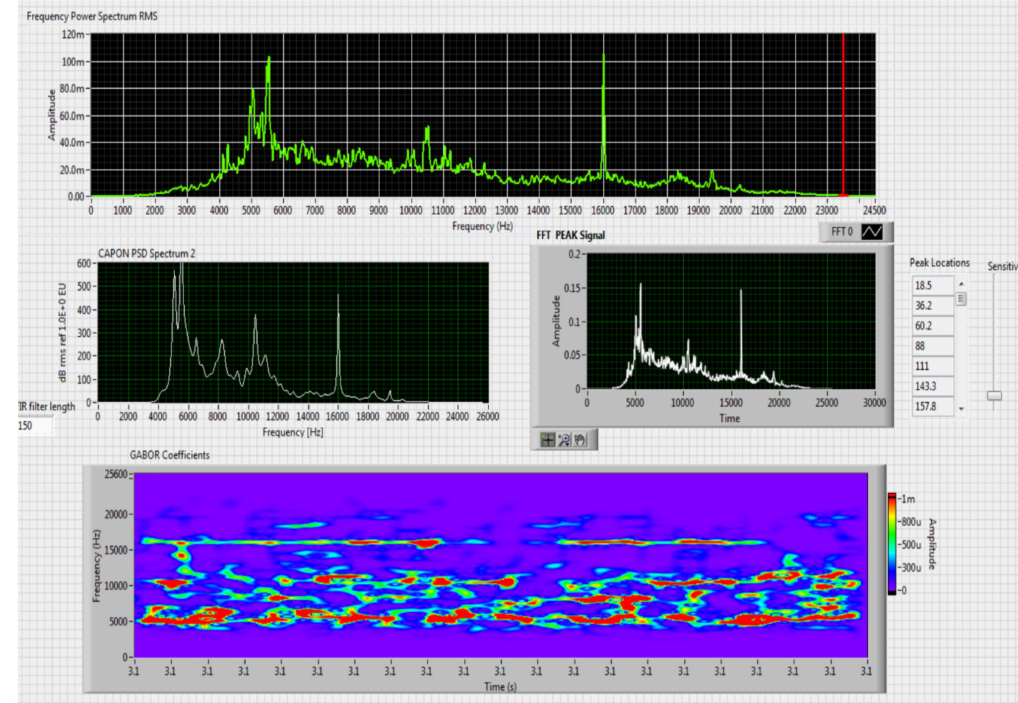
Figure 14. Results obtained for stationary distance 150 m, altitude 3